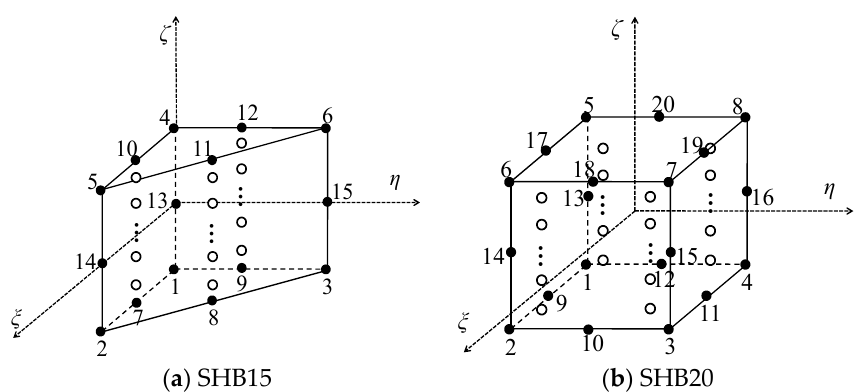
Figure 1. Reference geometry of ( a ) quadratic prismatic SHB15 element and ( b ) quadratic hexahedral SHB20 element, and position of the associated integration points.